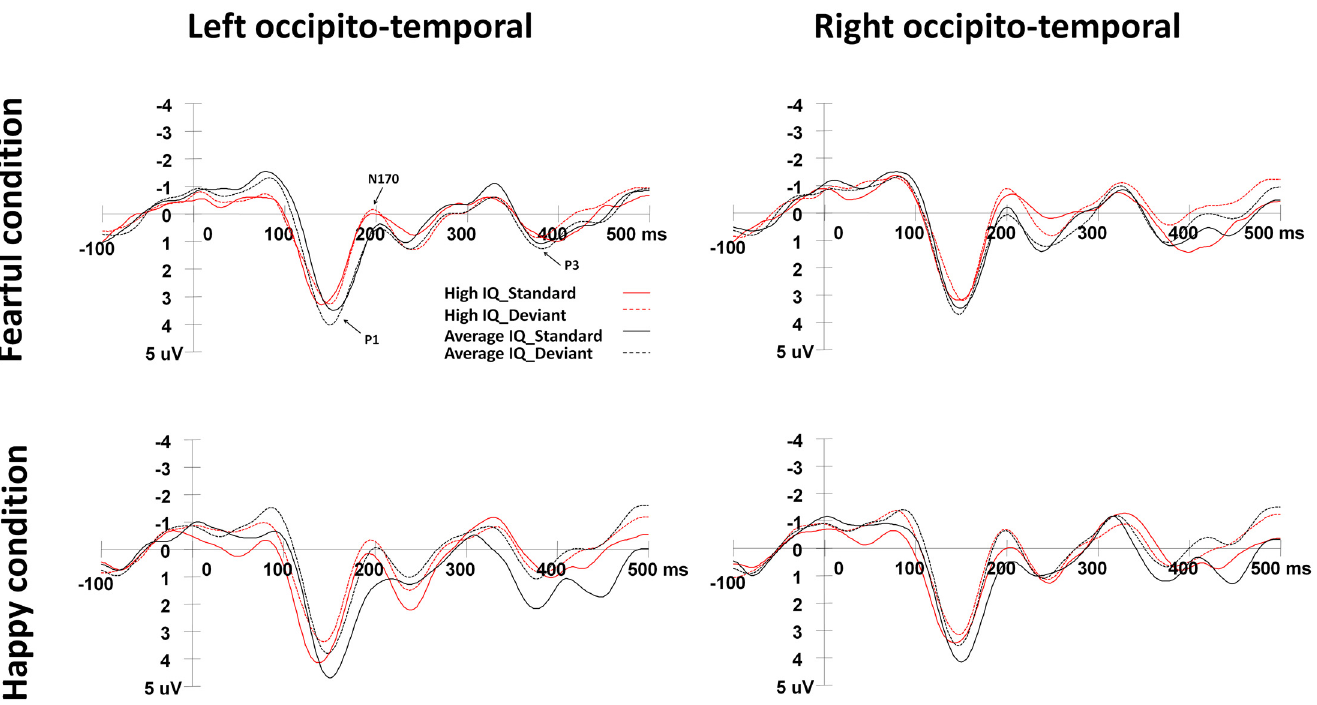
Fig 2. ERPs elicited by the standard and deviant stimuli in the happy and fearful oddball conditions. The left occipito-temporal waveform was the average neural activation at electrodes TP7, P7, PO7, CB1, and O1. The right occipito-temporal waveform was obtained from the average of TP8, P8, PO8, CB2, and O2.